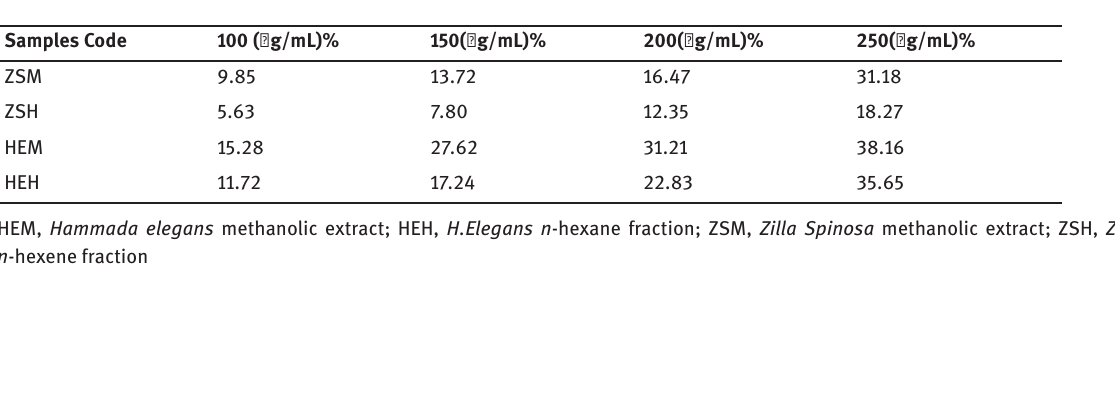
Table 4: Antioxidant Activities of